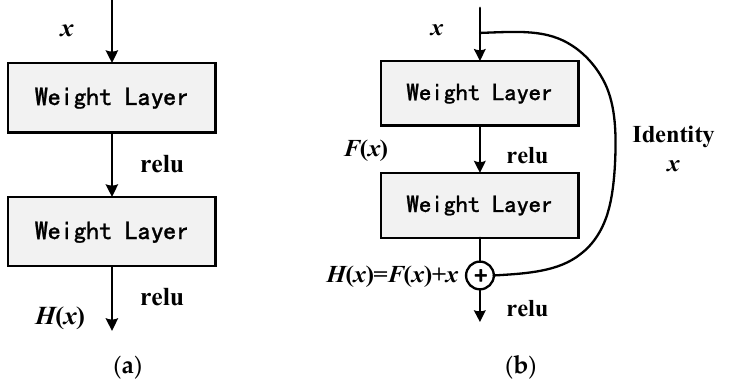
Figure 1. Residual unit. ( a ) Standard network structure diagram; ( b ) ResNet structure diagram.